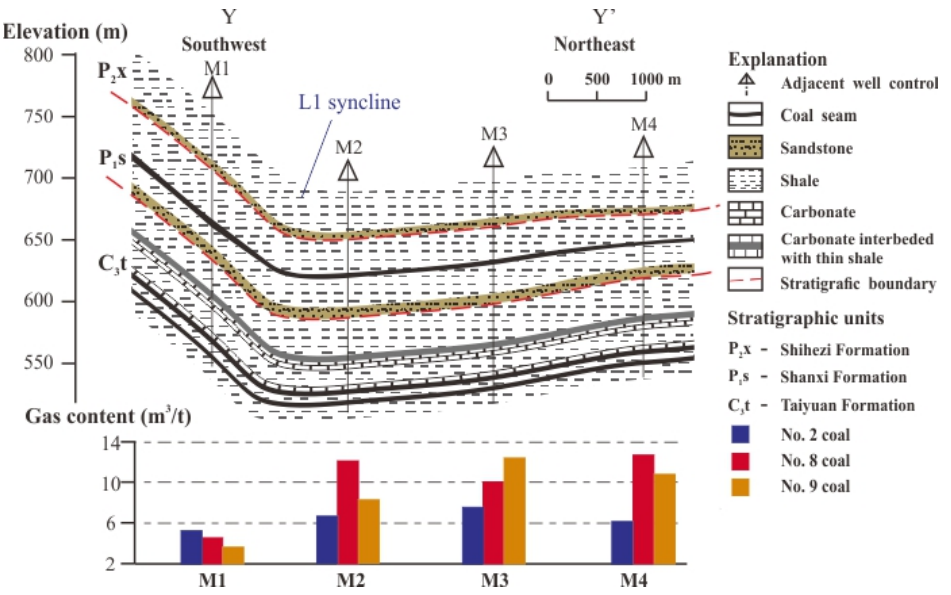
Figure 5. A SW–NE structural cross section of the Malan syncline. Gas content distribution refers to profile Y–Y’ in Figure